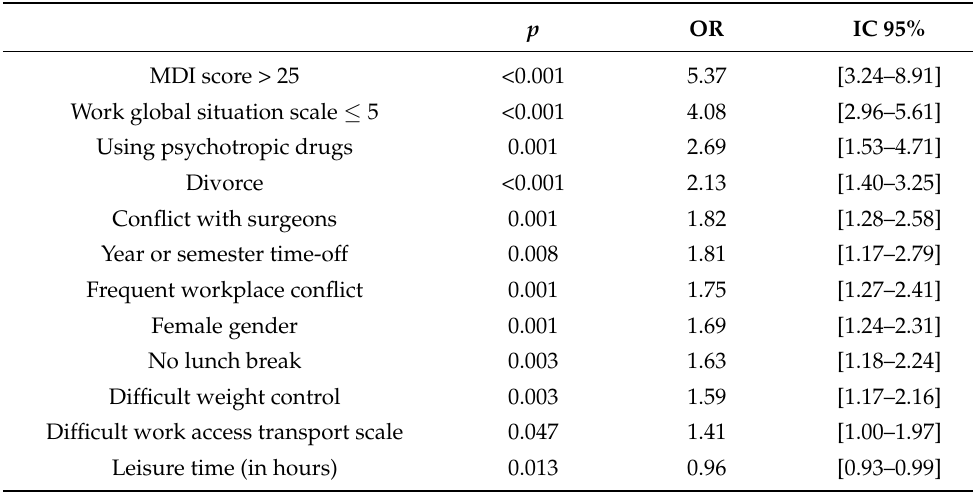
Table 3. Multivariate analysis with variables significantly associated with the criterion “ average personal and work-related burnout scores strictly greater than 50% ” .